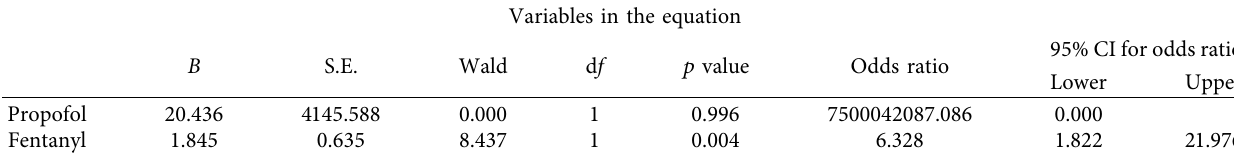
Table 7: Sedations used and occurrence of